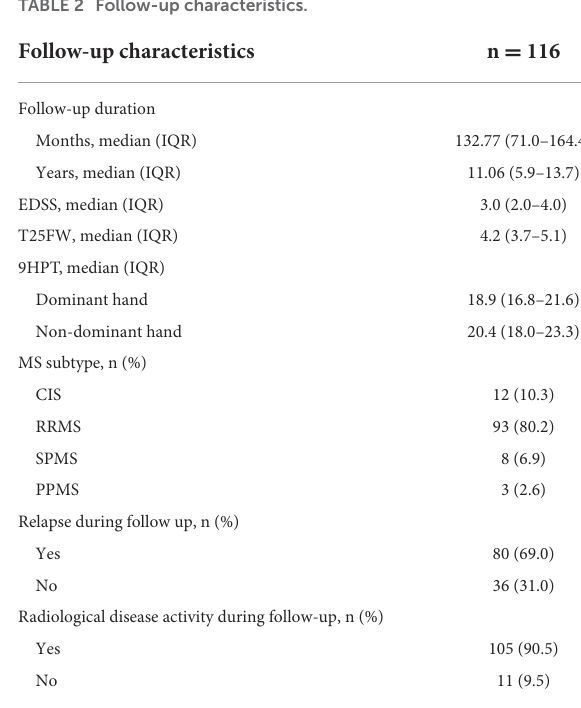
TABLE 1 Baseline